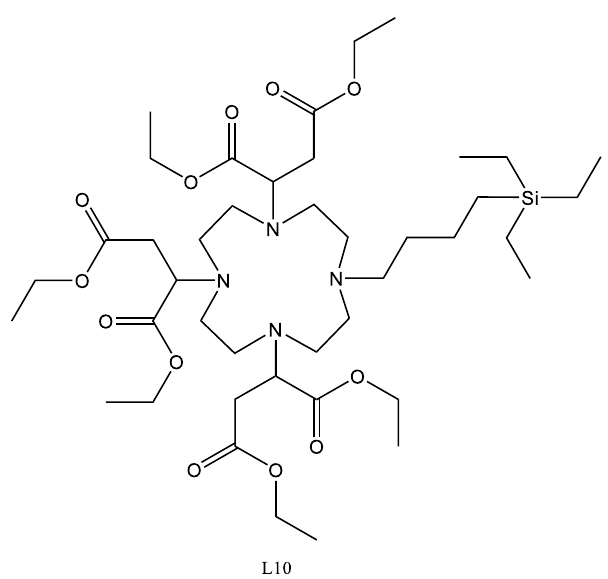
Figure 3. A cyclen based ligand attached to a silicone moiety.